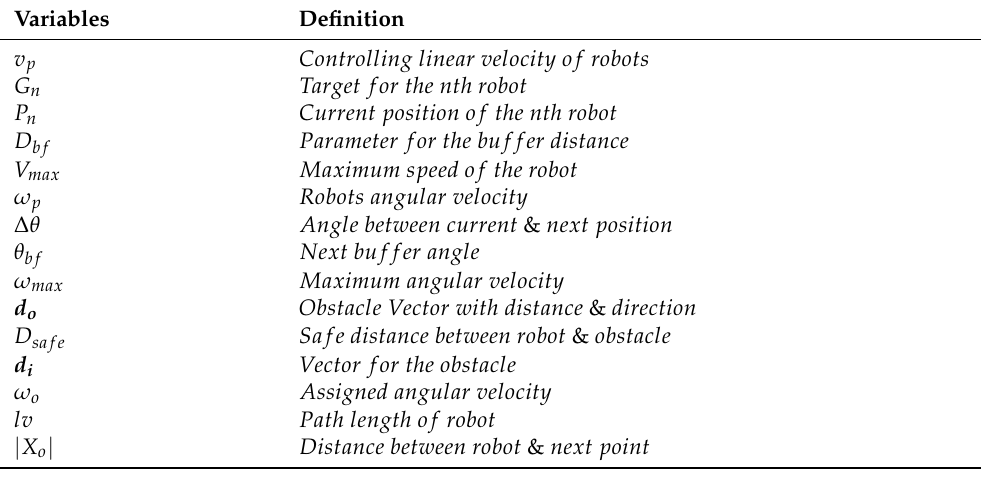
Table 2. Definition of the variables taken into the equations.